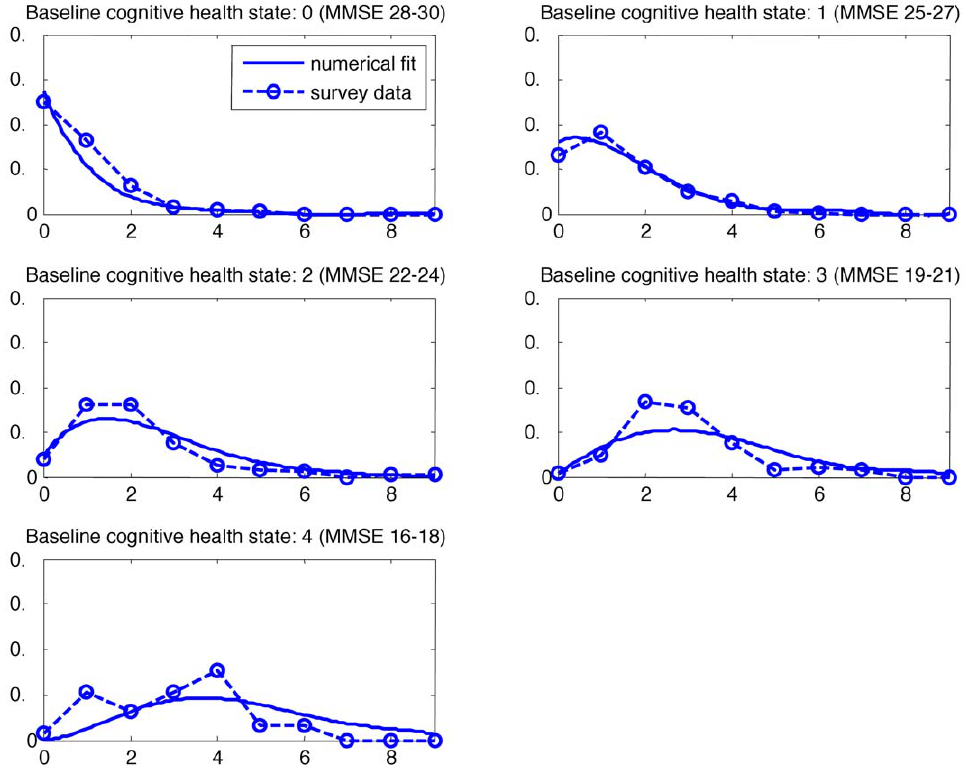
Figure 2. A graph showing change in health state (placebo group) at two years, by baseline health state. doi:10.1371/journal.pone.0011775.g002 and that predicted by the model (i.e. a fitted distribution). In each figure there are five graphs, the first graph represents those participants who were in cognitive health state 0 (MMSE 28–30)